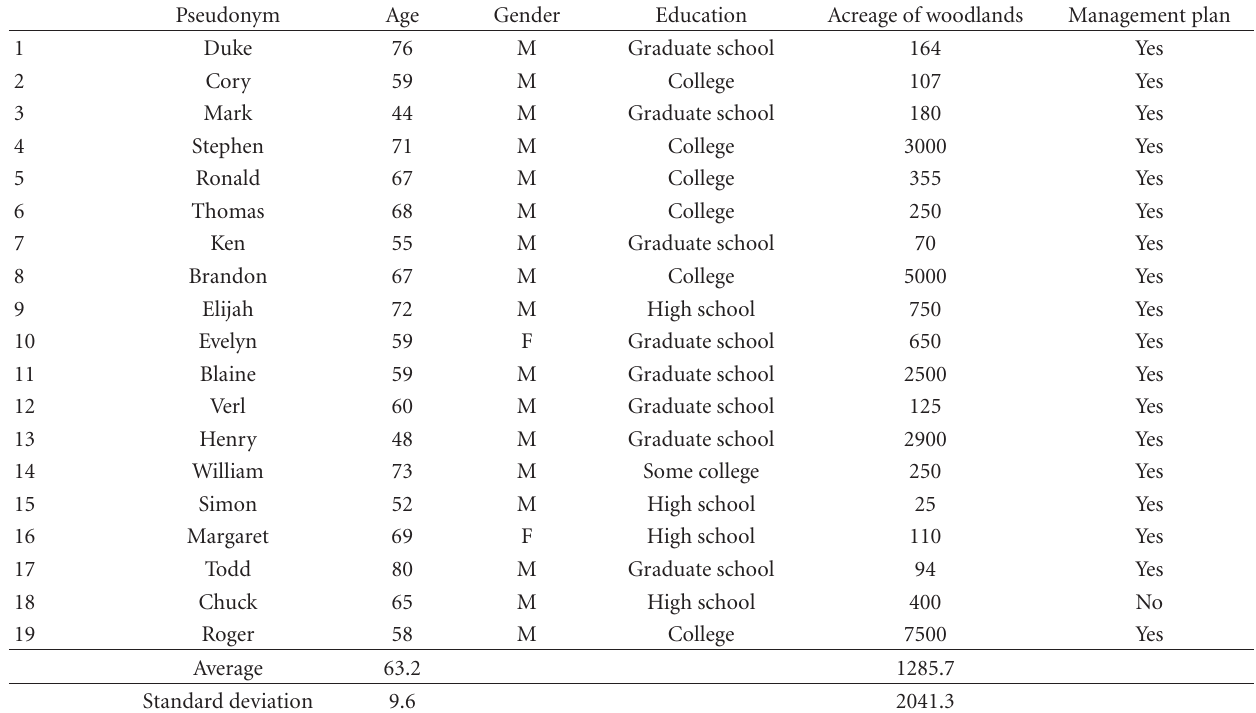
Table 4: Landowner